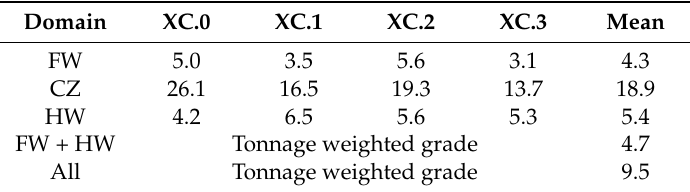
Table 10. Plant head grades (g/t Au) for SVZ mineralisation domains across